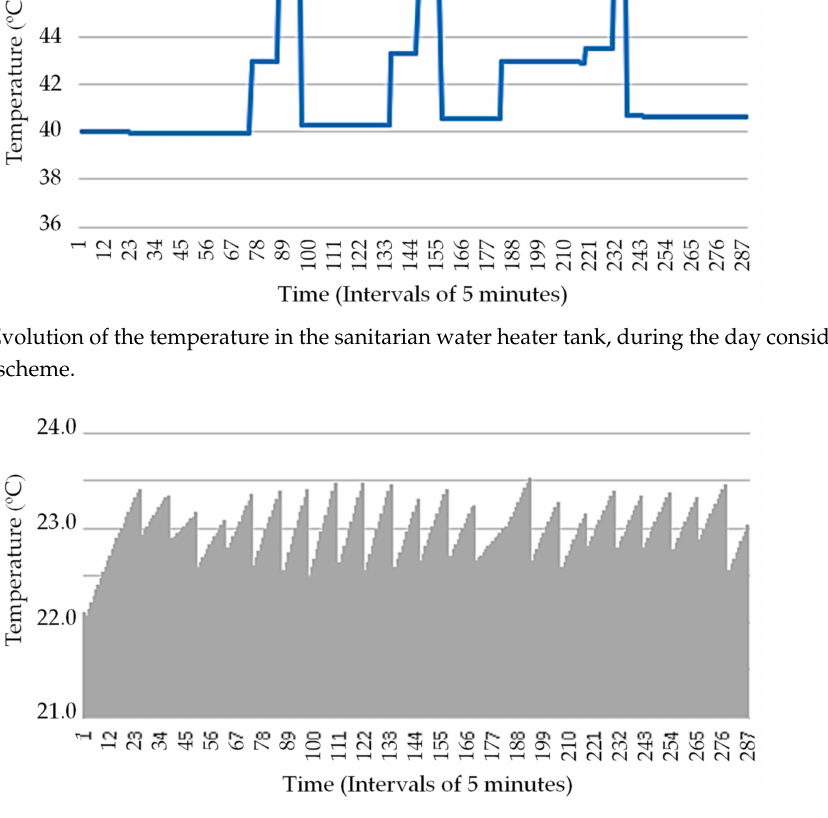
Figure 13. Evolution of the environmental temperature in the smart house, during the day, considering the time of use